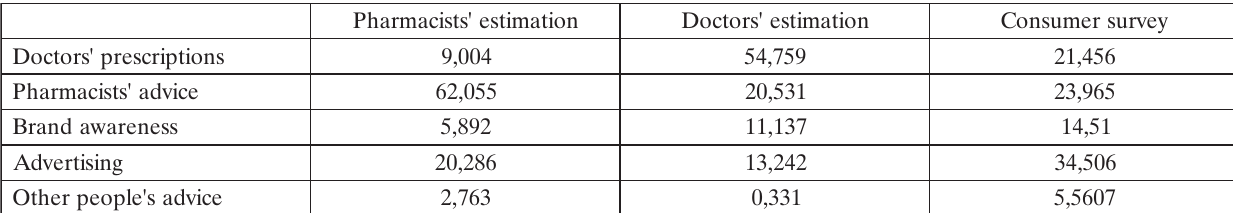
Table 5. The main influences that determine choice of